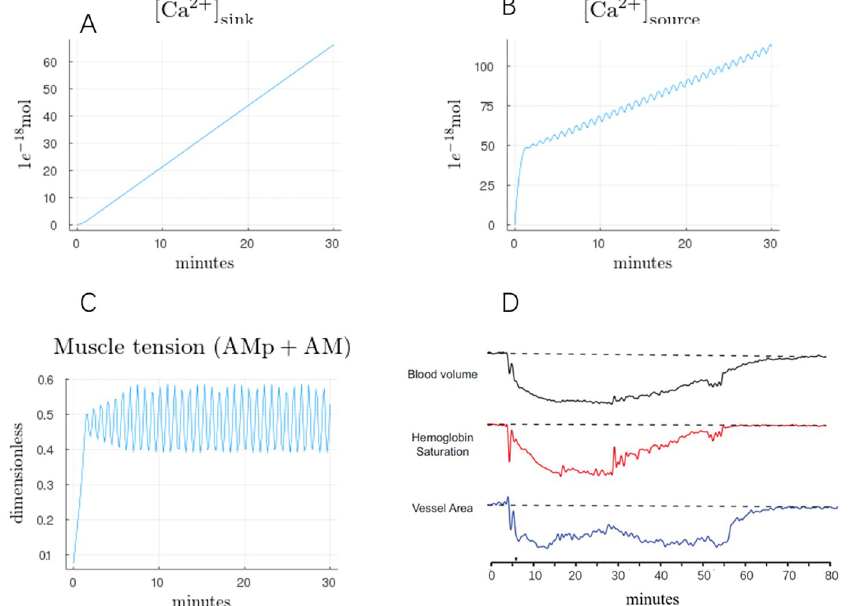
Fig 4. Cumulative calcium movement and vascular activity as a consequence of elevated mitochondrial calcium ([Ca 2+ ] mit = 0.25 μ M). A) Sink refers to the cumulative calcium exiting the cell and entering the ECS. B) Source refers to the cumulative calcium exiting the mitochondrial matrix. All concentrations relative to the cytoplasmic volume which is assumed to be 0.7 pL. C) Muscle tension predicted by our model. D) Trace similar to Fig.4A in [12], showing in-vivo vascular dynamics following CSD.